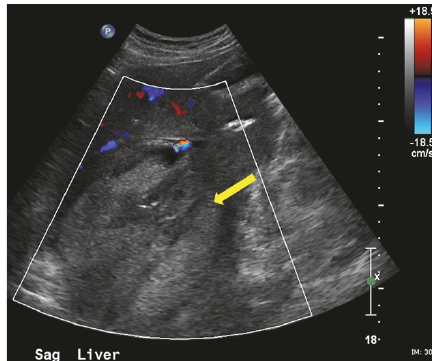
Figure 4: Postembolization color Doppler ultrasound demonstrat- ing echogenic thrombus occupying the aneurysm sac with near total absence of color flow (yellow